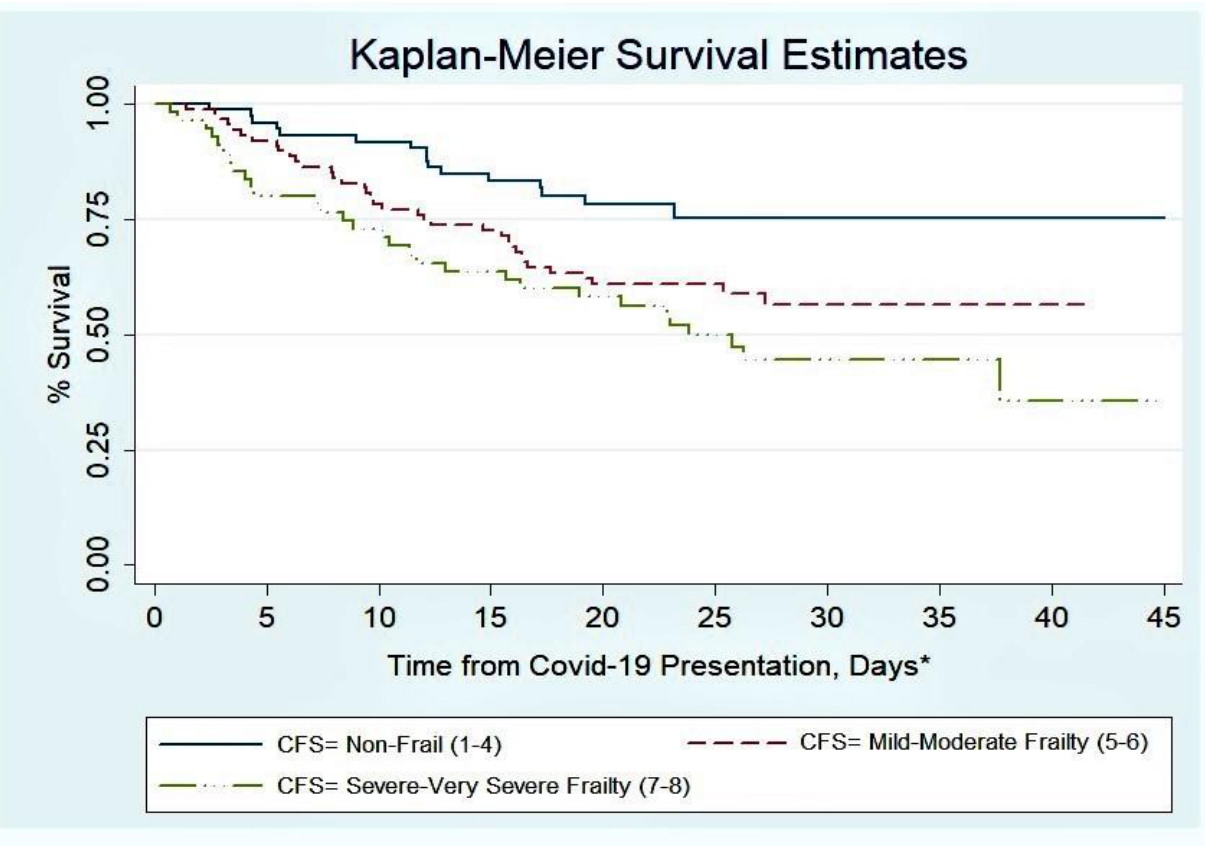
Figure 2. Survival after presentation with COVID-19 infection by Clinical Frailty Scale (CFS) Score. * The time from COVID-19 presentation is defined as the number of days from either admission to hospital or time from first positive swab if hospital acquired disease. For those discharged alive, follow-up was extended for the first 14 days after discharge.